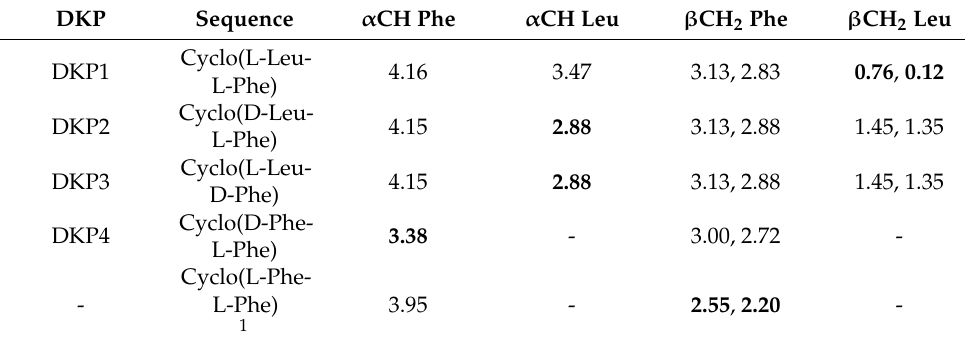
Table 2 . NMR shifts in deuterated DMSO of α CH and β CH protons of DKPs 1–4. Values in bold indicate upfield shifts due to intramolecular CH- π interactions.